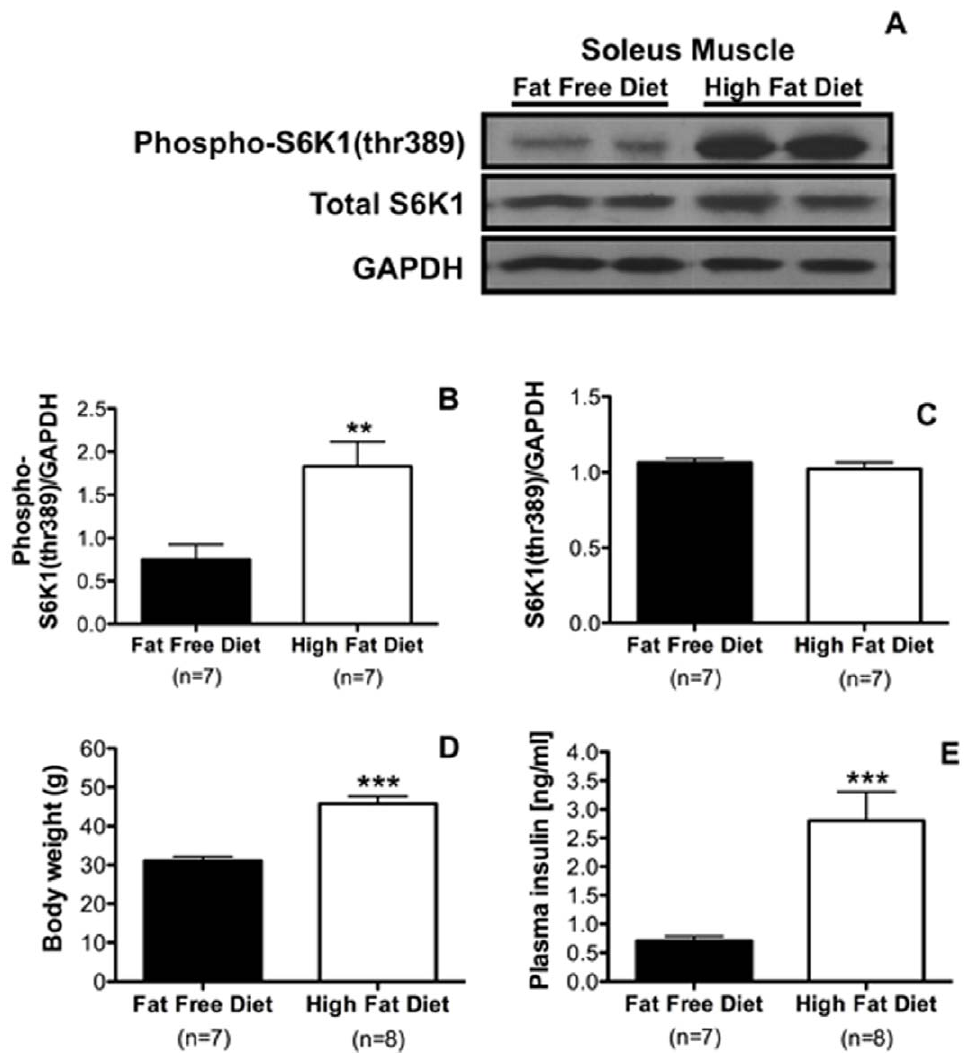
Figure 2. Dietary fatty acids activate S6K1 in muscle. Mice fed a high-fat diet for 6 wk show significantly higher phosphorylated S6K1 (A, B) with no changes in total S6K1 protein levels when compared to control mice fed a fat-free diet (C). Body weight (D) and plasma insulin levels (E) were significantly higher in mice on a high-fat diet. Two tailed t test ** P , 0.01, *** P , 0.001.